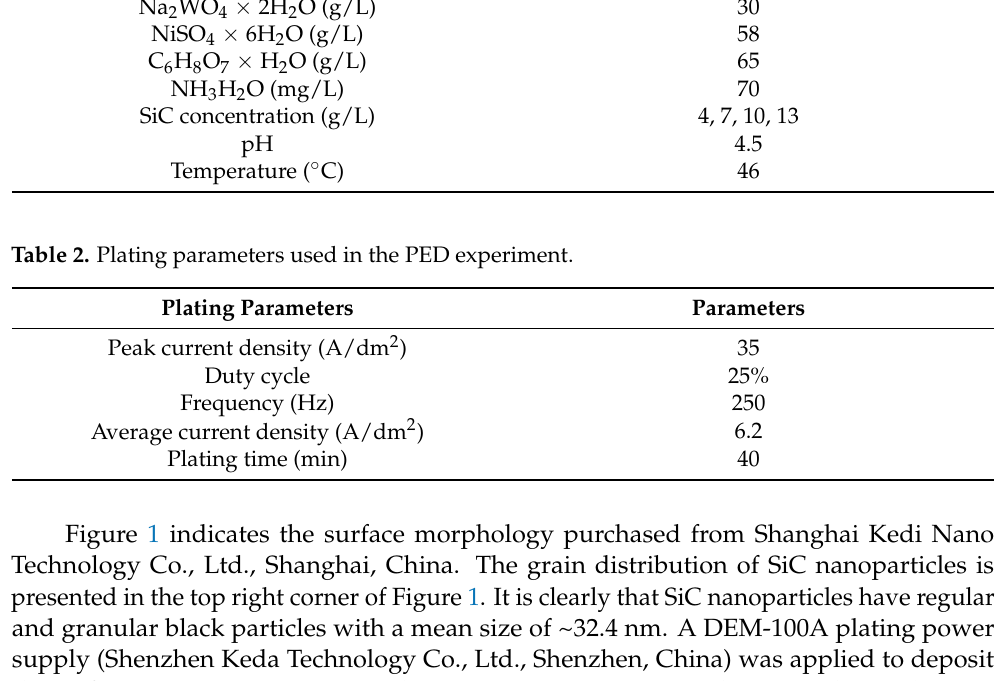
Table 1. Composition of the bath solution for depositing Ni/W-SiC nanocomposites. Compositions Parameters